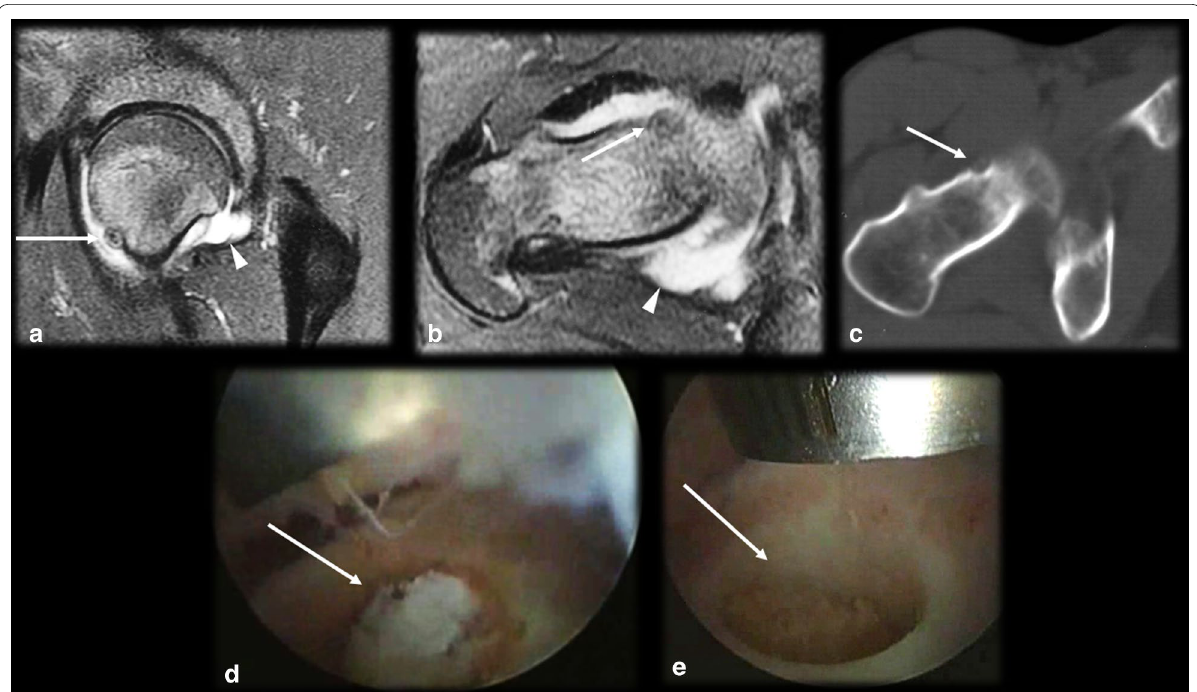
Fig. 4 Osteoid osteoma mimicking synovitis of the hip. A 24-year-old man with right hip pain, swelling and tenderness for 2 weeks. Inflammatory marker levels were also elevated. Orthopedists suspected inflammatory arthropathy, and ultrasound (not shown) depicted joint effusion and synovitis. MRI T2 FS sagittal ( a ) and axial ( b ) shows joint effusion (arrowhead) with synovial thickening and a doubtful nidus (arrow), which was better characterized on the CT scan ( c ). Arthroscopic aspect before ( d ) and after ( e ) nidus resection